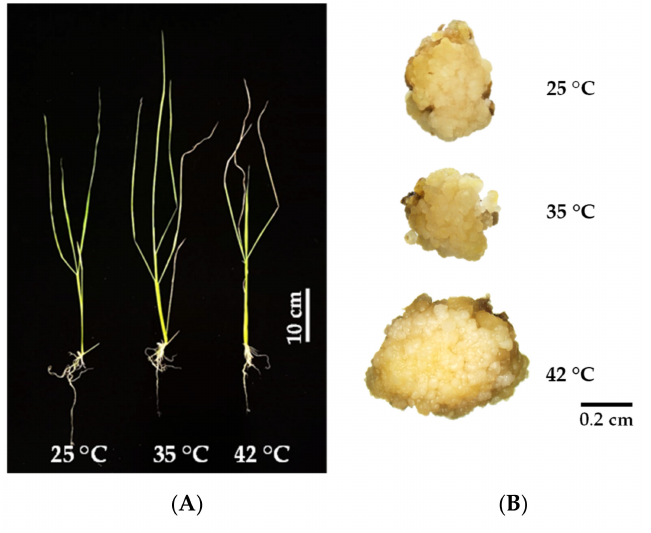
Figure 1. Effects of elevated temperatures (35 and 42 ◦ C) and normal temperature (25 ◦ C) on growth of KDML105 seedlings ( A ) and callus induction from KDML105 seeds ( B